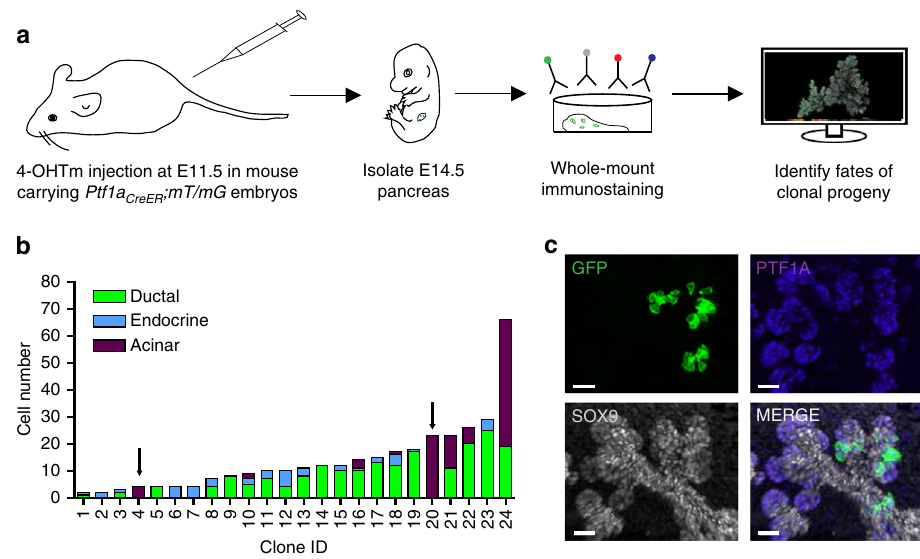
Fig. 6 Ptf1a CreER -mediated clonal analysis identi fi es unipotent acinar progenitors at E11.5. a Schematic overview of strategy applied to identify fates of clonal progeny from E11.5 pancreatic progenitors. b Quanti fi cation of clone sizes and fate compositions following Ptf1a CreER -mediated clonal analysis ( n = 24 clones in 70 embryos analysed). Arrows indicate two acinar unipotent acinar clones, as predicted by our mathematical model. c A representative 3D MIP of one of the two acinar unipotent clones. Most clones were found in the dorsal pancreas, except clones no. 2, 9 and 16 which were found in the ventral pancreas. Scale bars, 20 µ